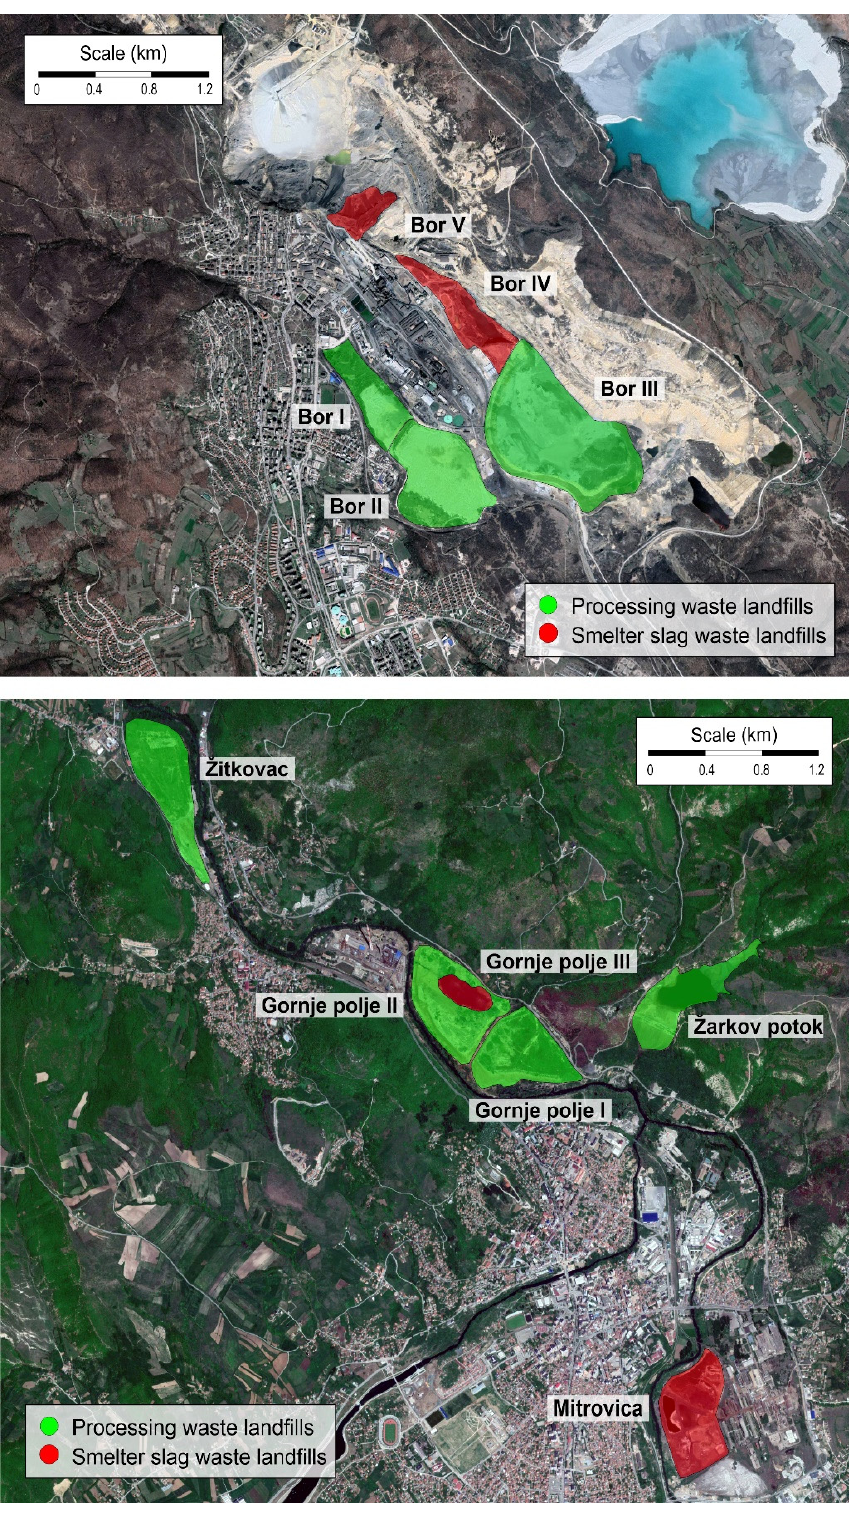
Figure 6. Bor ( above ) and Trep č a ( below ) mine districts.